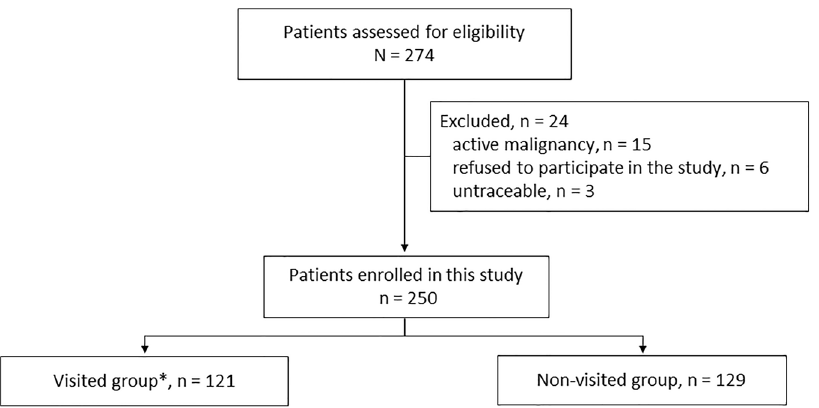
Figure 1. Allocation and course of study participants. RRT, renal replacement therapy; visited group*, those who visited an ESRD clinic and RRT selection with the SDM